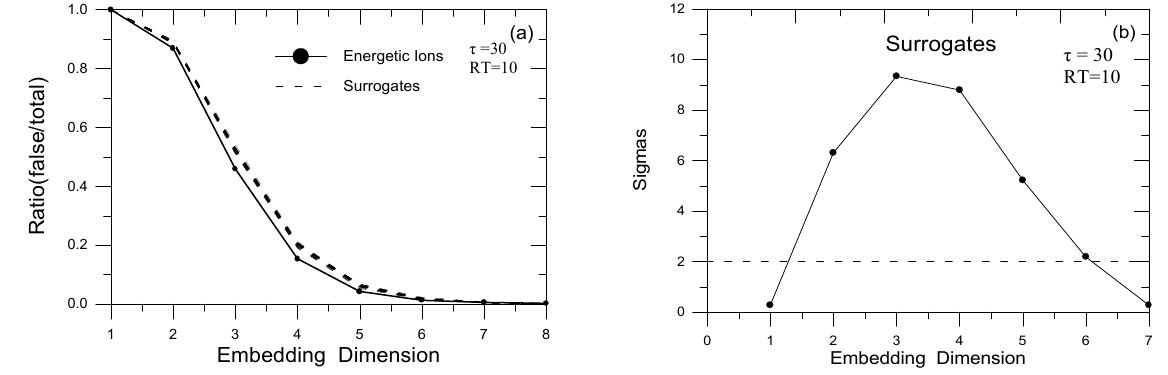
Figure 10 Fig. 10. (a) The ratio of the false to the total nearest neighbours for the original time series and its surrogate data as a function of m . For this